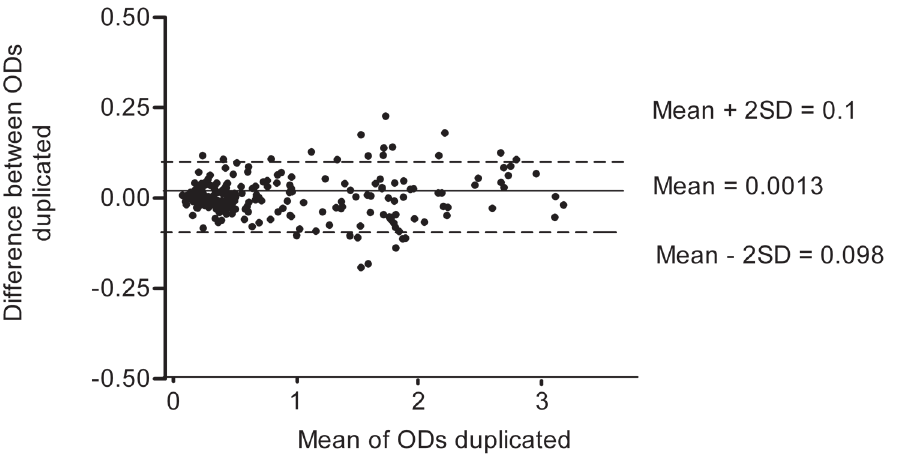
Figure 2. Scatter plot of the differences between the optical density (OD) of the serum duplicates and their means. OD was recorded at 450 nm.